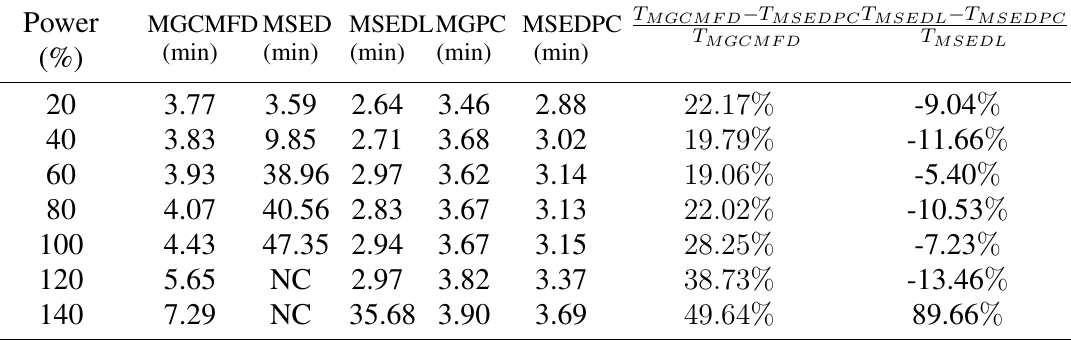
Table 4: Run Time for Problem 6–Single State